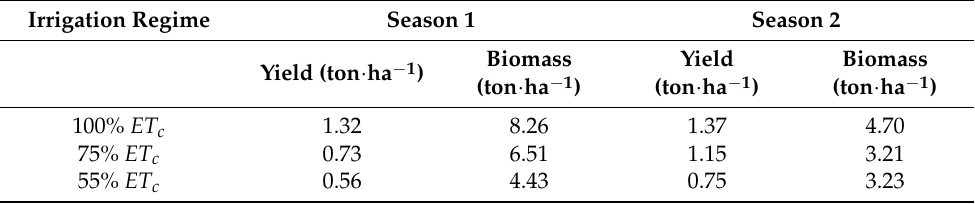
Table 7. Summarised observed yields and biomass accumulation over two growing seasons. Irrigation